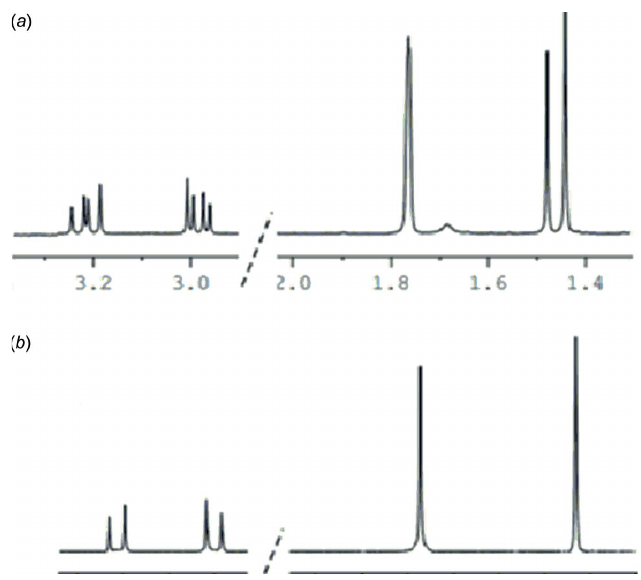
Figure 4 1 H NMR spectra of ( a ) the diastereoisomeric mixture 3 and ( b ) the pure separated (5 R ,5 0 R ) diastereoisomer 3a .